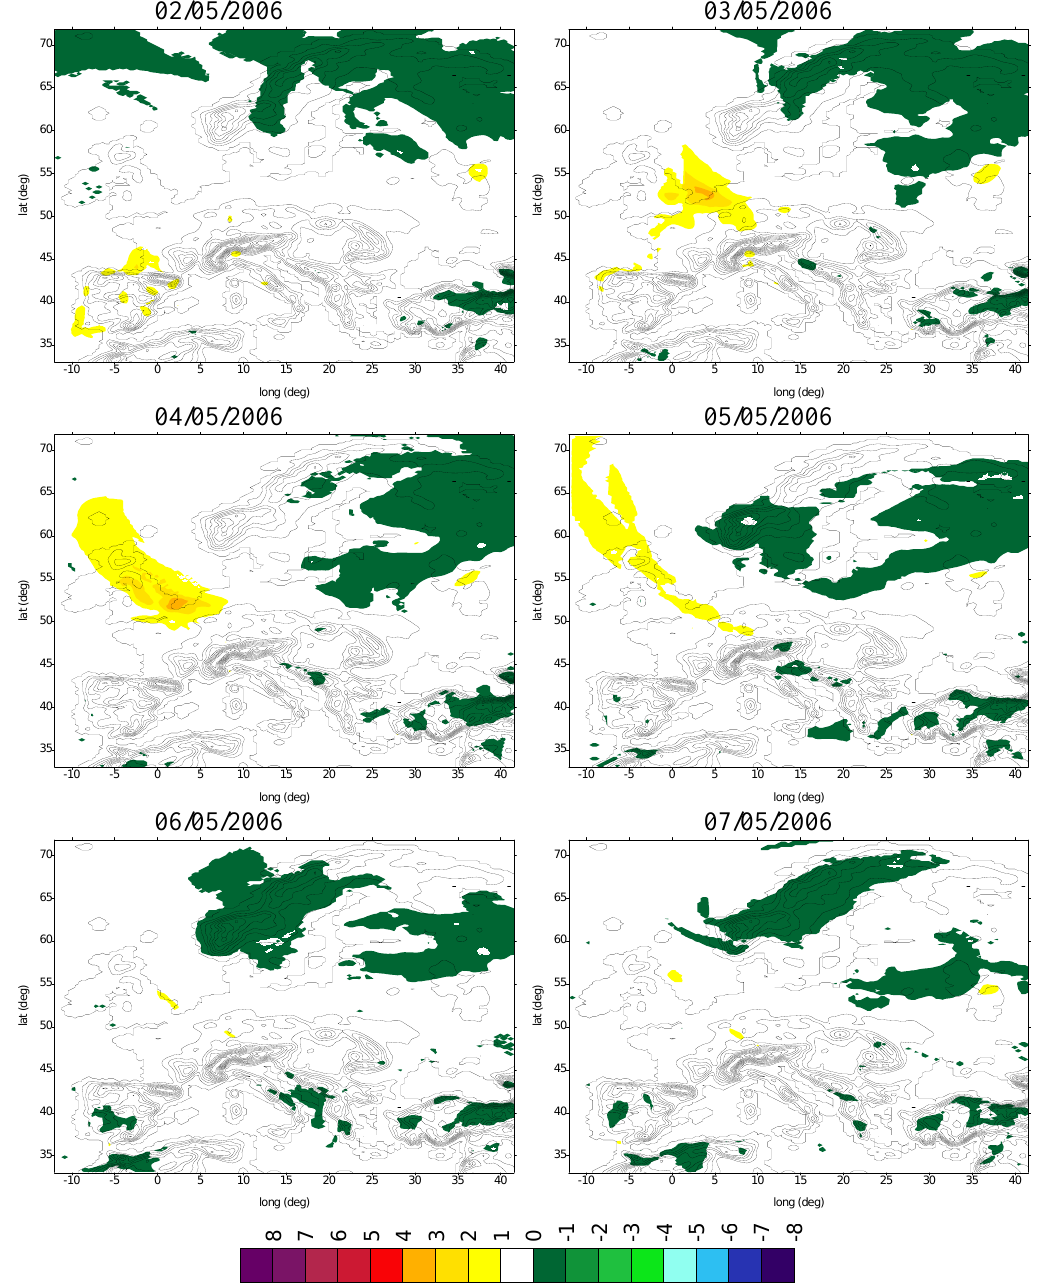
Fig. 10. Pure contribution of biogenic emissions to maximum hourly surface O 3 (ppb) during the period 2–7 May 2006.